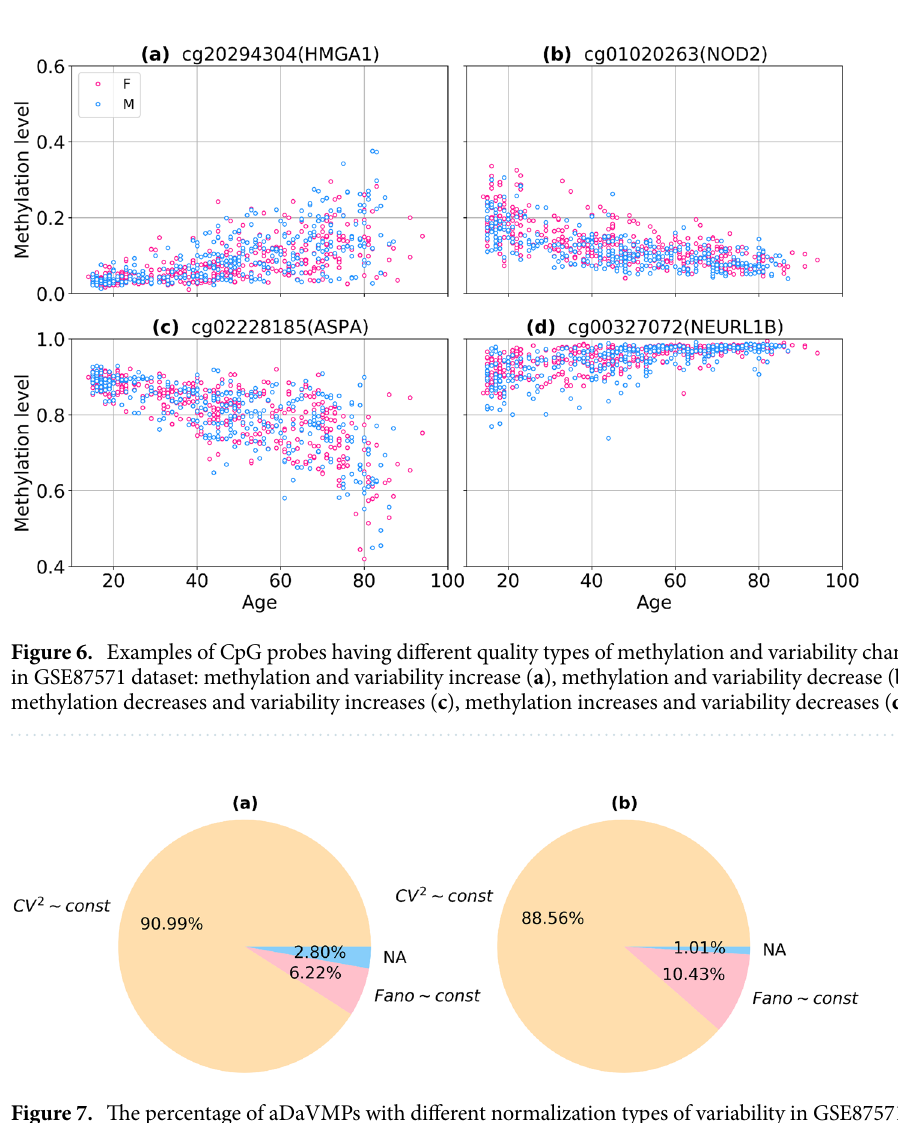
2 ∼ const 2 ∼ β 2 ( CV , beige); with functional 2 and F did not pass by p value (‘NA’